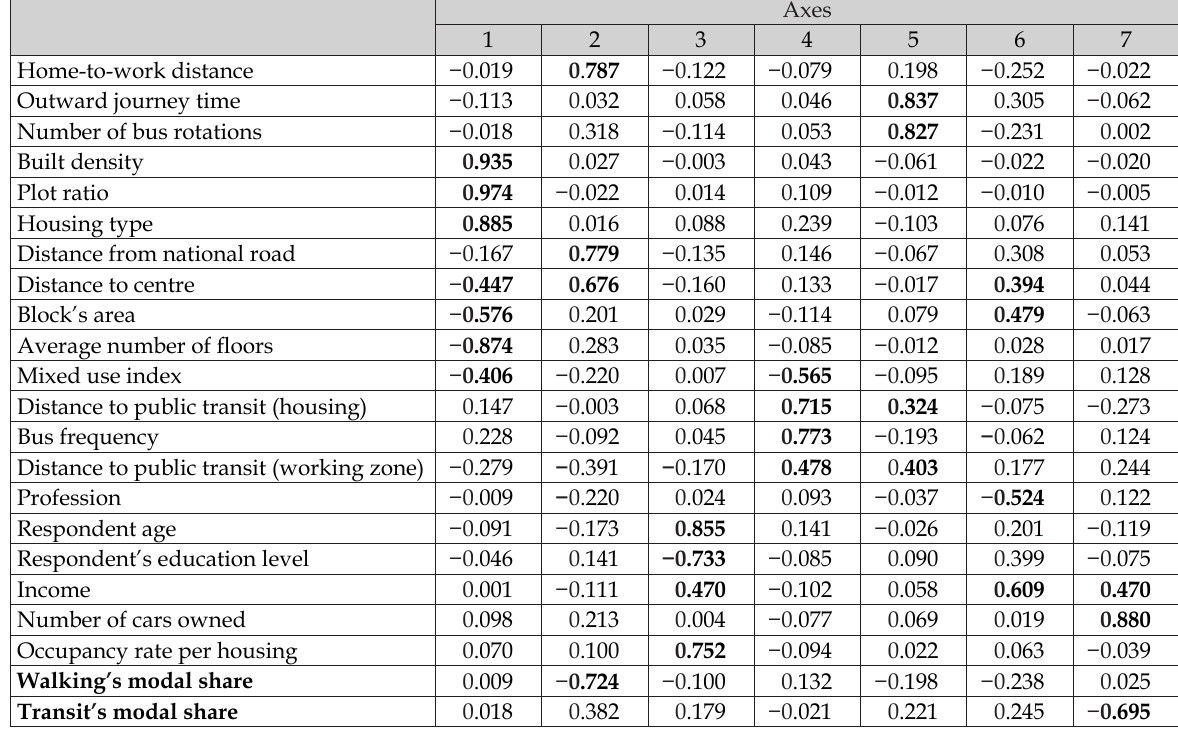
fig. 10. Hypothetical causal pathways between variables and the modal share of the car. Source: own Table 5. Projection of explanatory variables for the modal share of walking and transit. Axes